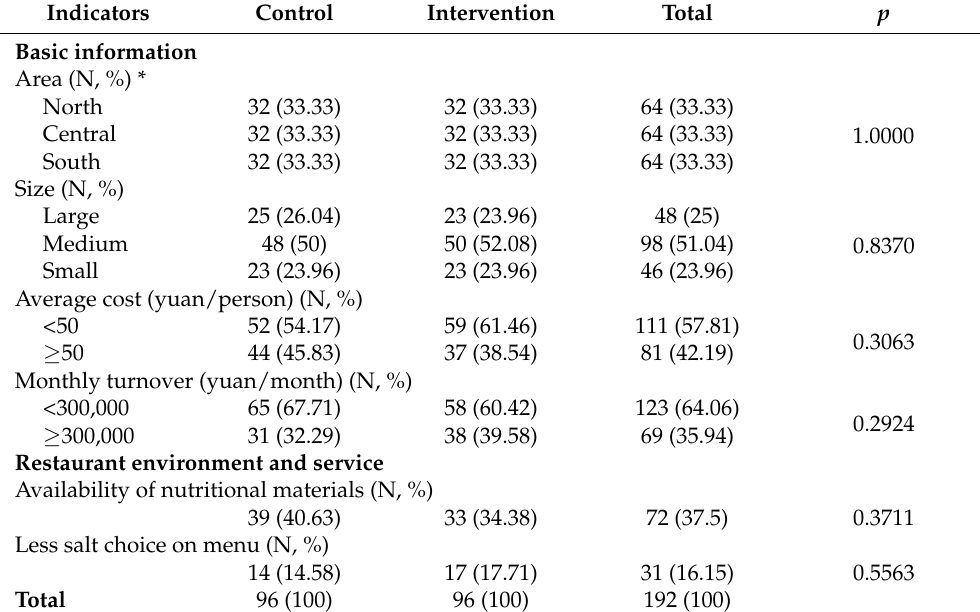
Table 1. Baseline characteristics of